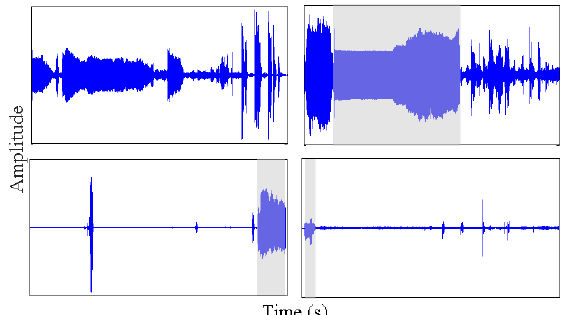
Figure 3. Illustrative examples of voice clinimetric test sensor data recorded using a smartphone microphone from healthy individuals and those with PD. The top two tests are performed by healthy individuals and the bottom two by PD patients. Voice tests take approximately 20 s, and the shaded area marks the part of the test where the user adheres to the test